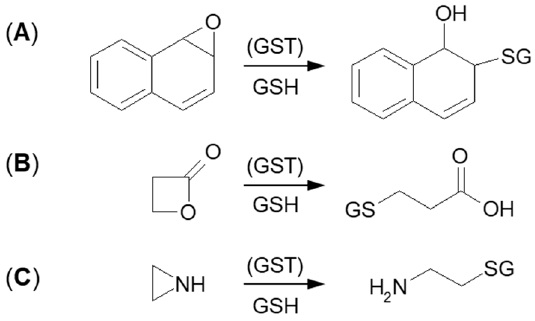
Figure 6. GSH conjugation via opening the tensioned ring of ( A ) epoxy, ( B ) lactone, and ( C ) aziri-